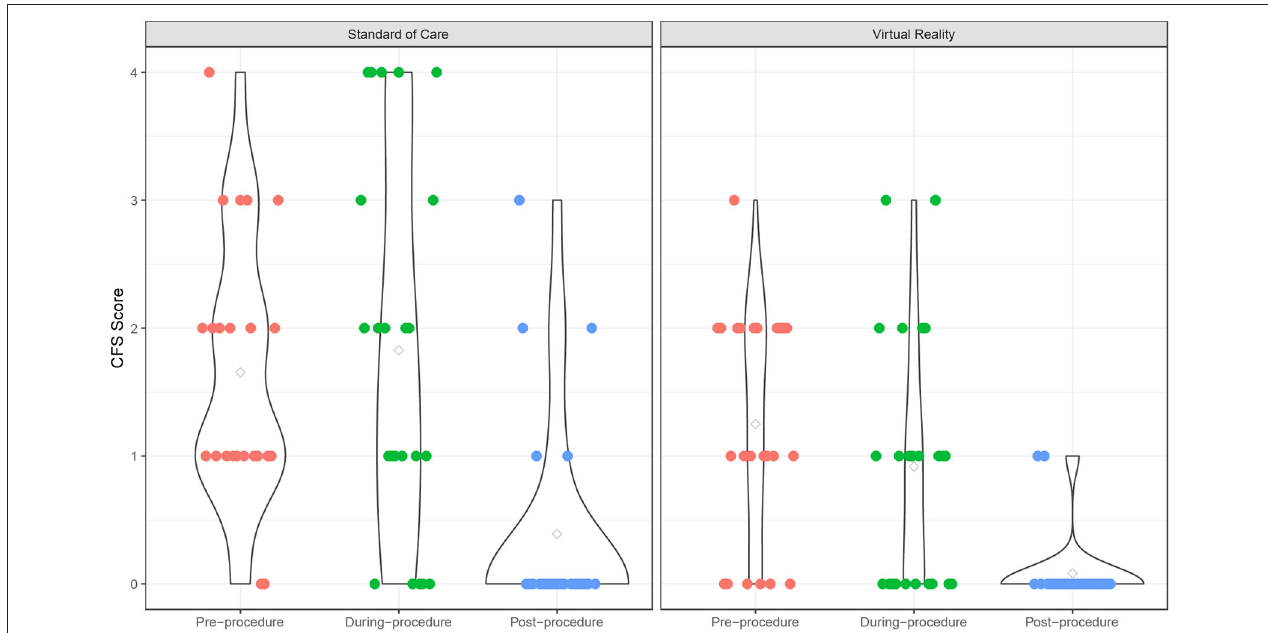
FIGURE 2 | Fear score over time. Fear scores of Virtual Reality (VR) and SOC groups as measured by the Children’s Fear Scale (CFS).